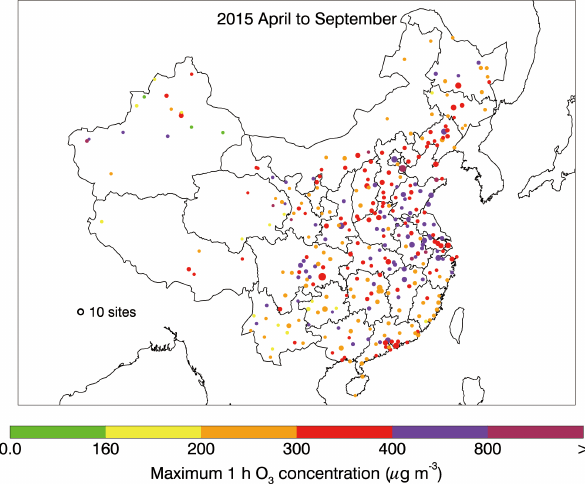
Figure 2. Distribution of observed maximum 1h [O 3 ] in mainland China from April to September 2015.